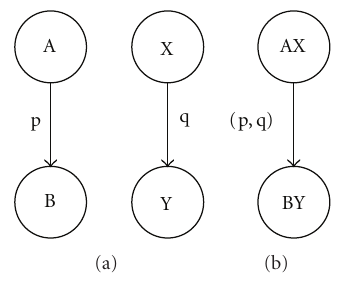
Figure 2: Parallel